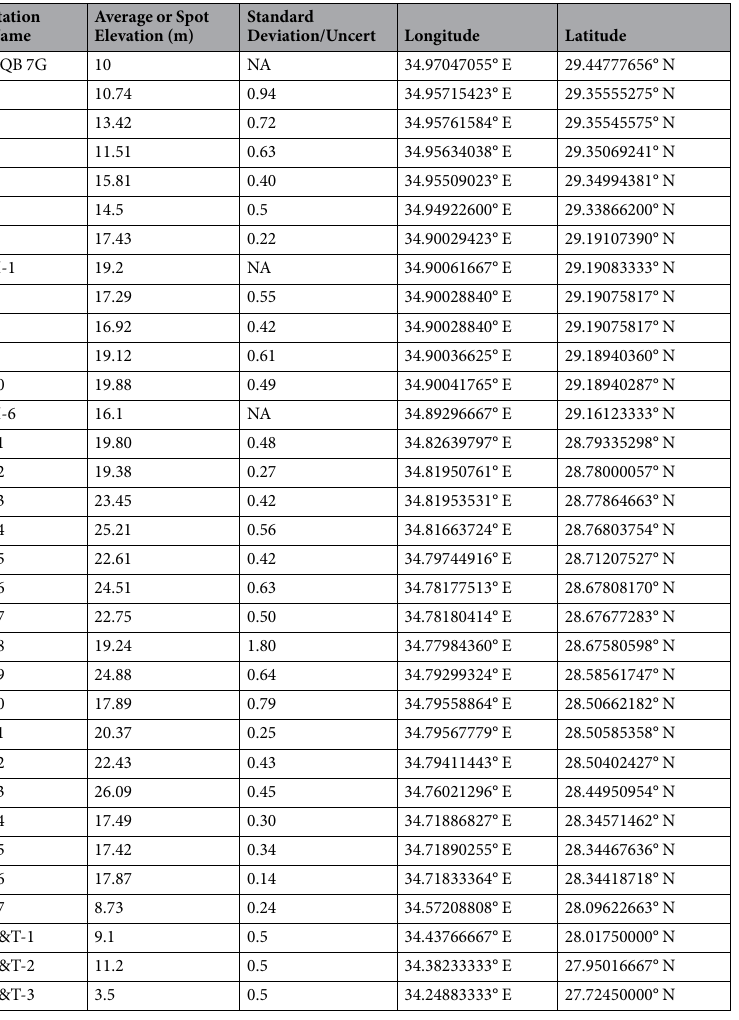
Table 1. Last interglacial (MIS5e; ~125 ka) coral terrace stations along the eastern margin of the Gulf of Aqaba and southeastern Sinai. Sites are listed from north to south. NA indicates that no measure of elevation uncertainty was provided in the source publication. AQB 7G is the only location in Jordan and is from ref. 46. H-1 and H-6 are from ref. 44. B&T-1, 2 and 3 are located on the southeast coast of Sinai, Egypt 23 . Our elevations are local relative measurements directly from sea level and uncorrected for tides. Datum is WGS84. Locations are shown in Fig.